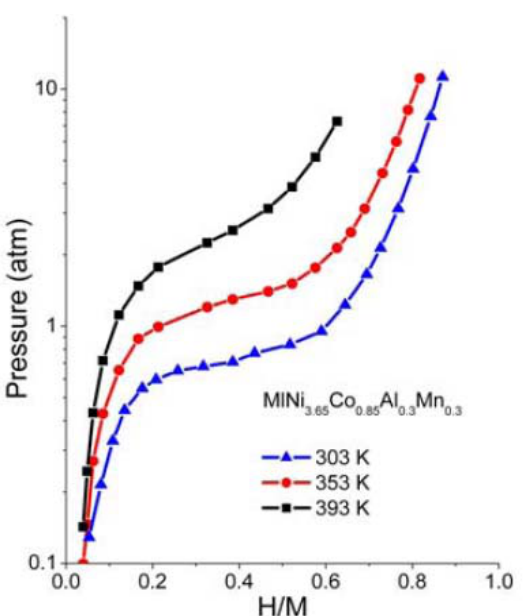
Figure 6. p-c-T isotherms for